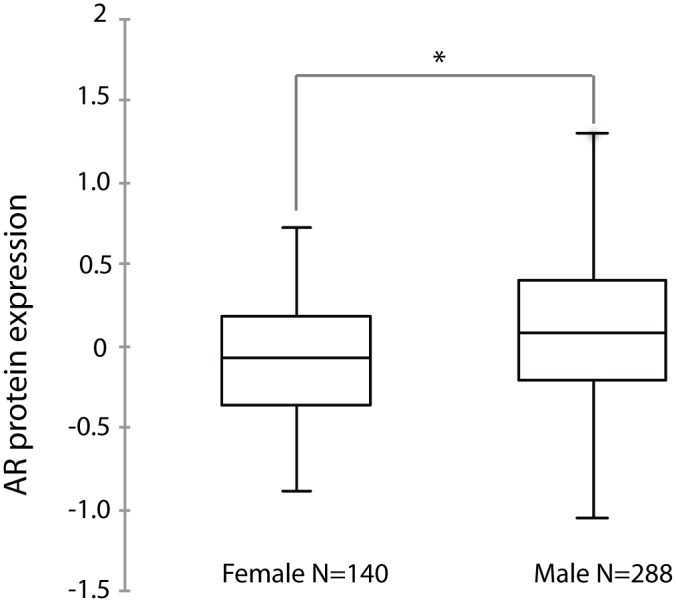
Box plot of AR protein expression in male and female ccRCC patients.* indicates statistical significance (p<0.05) by student’s t-test.